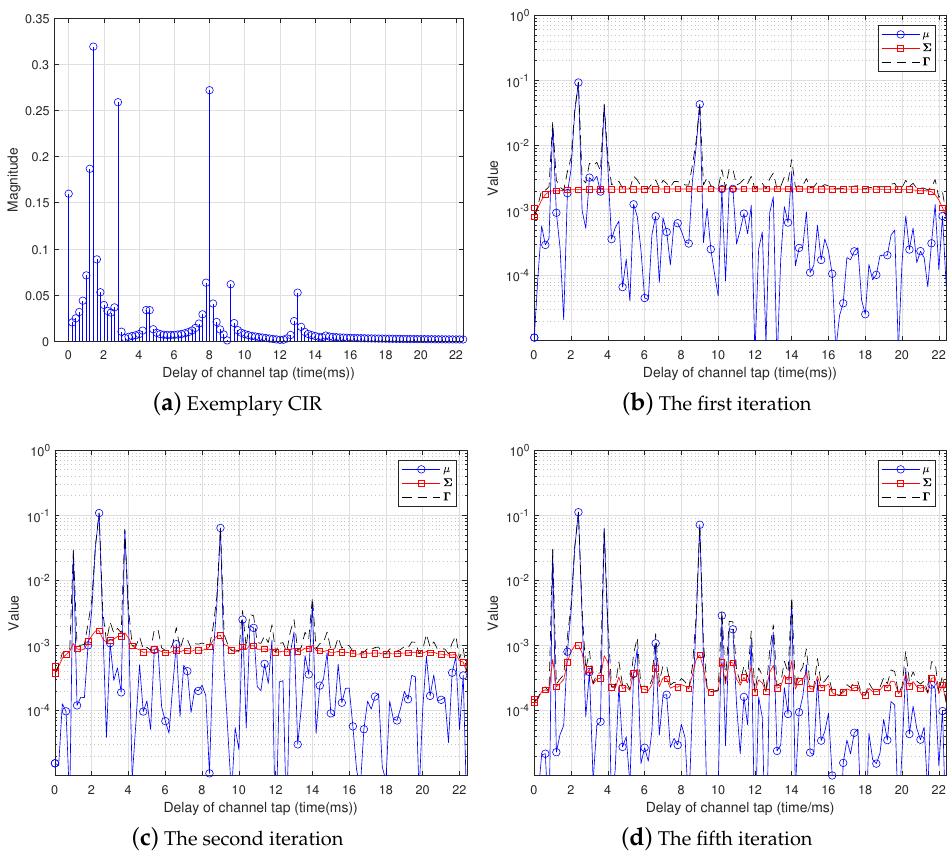
( d ) The fifth iteration